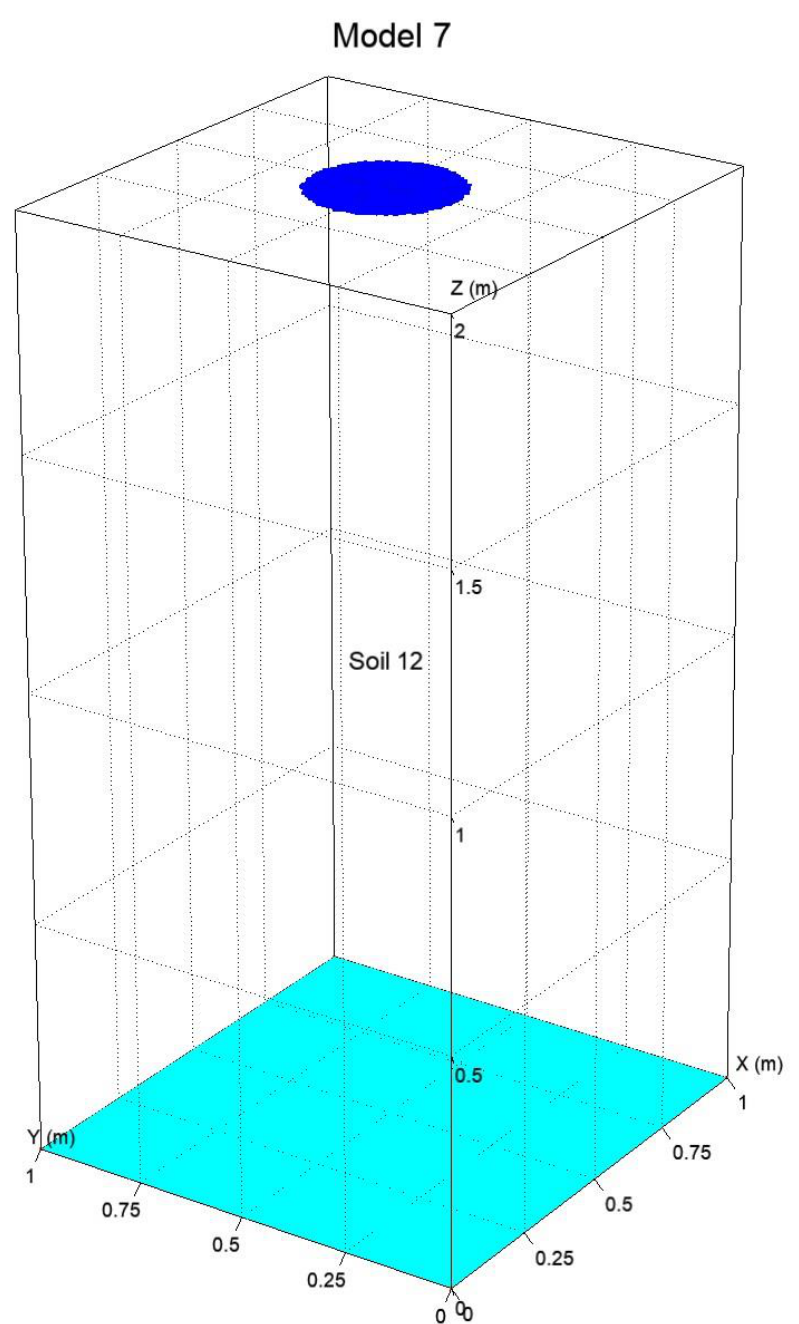
Figure 2. Overview over Model 7. Blue depicts a constant pressure head boundary condition, cyan depicts a free drainage boundary condition. The rest of the surface of the cuboid has a no-flow boundary condition which is not depicted.